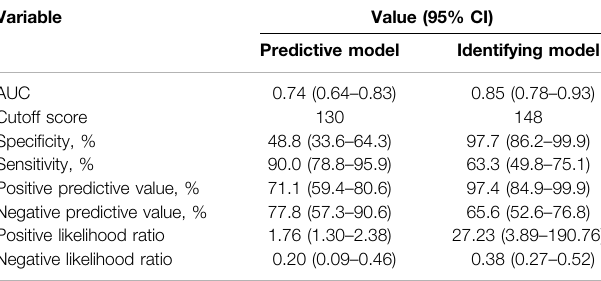
TABLE 4 | Accuracy of two nomograms for predicting and identifying power